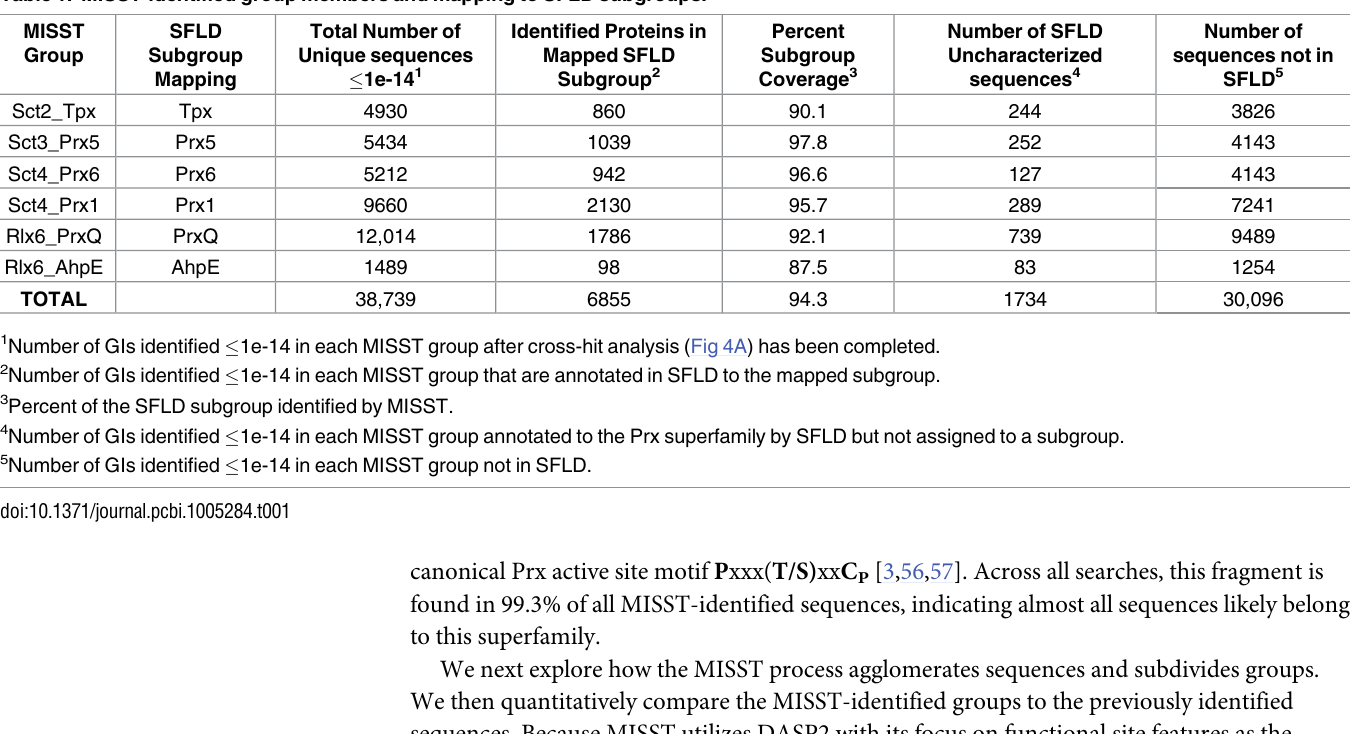
Table 1. MISST-identified group membersand mapping to SFLD